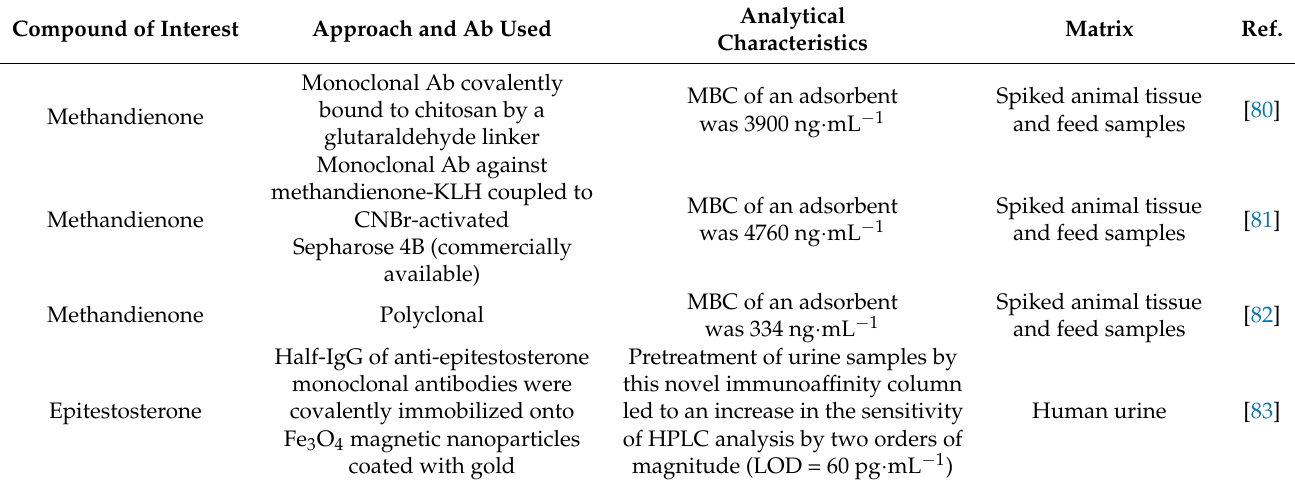
Table 1. Immunoaffinity columns for the determination of anabolic-androgenic